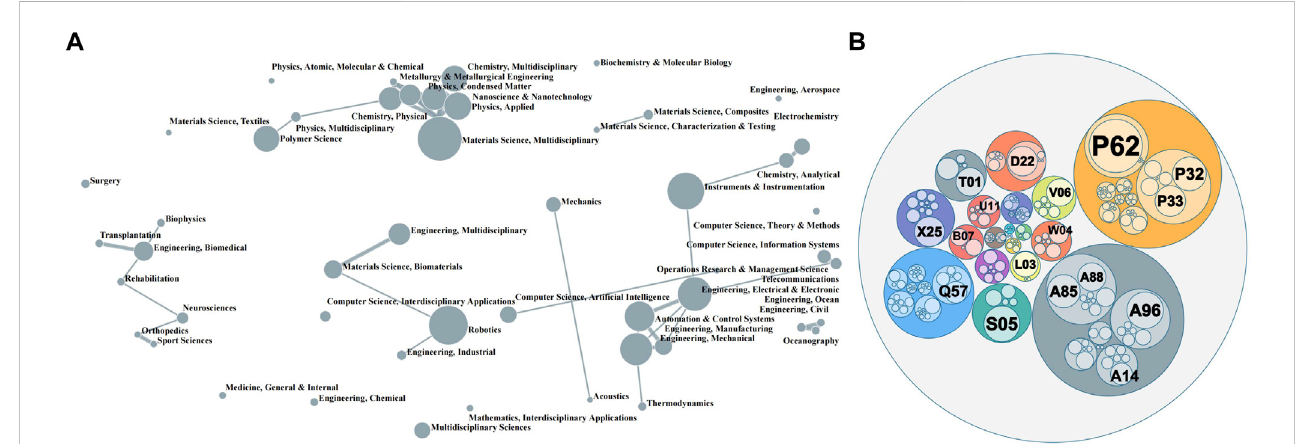
FIGURE 3 Cluster map of arti fi cial muscle scienti fi c and technological innovation fi elds (A) cluster of papers ’ WoS categories; (B) cluster of patents ’ DWPI categories.